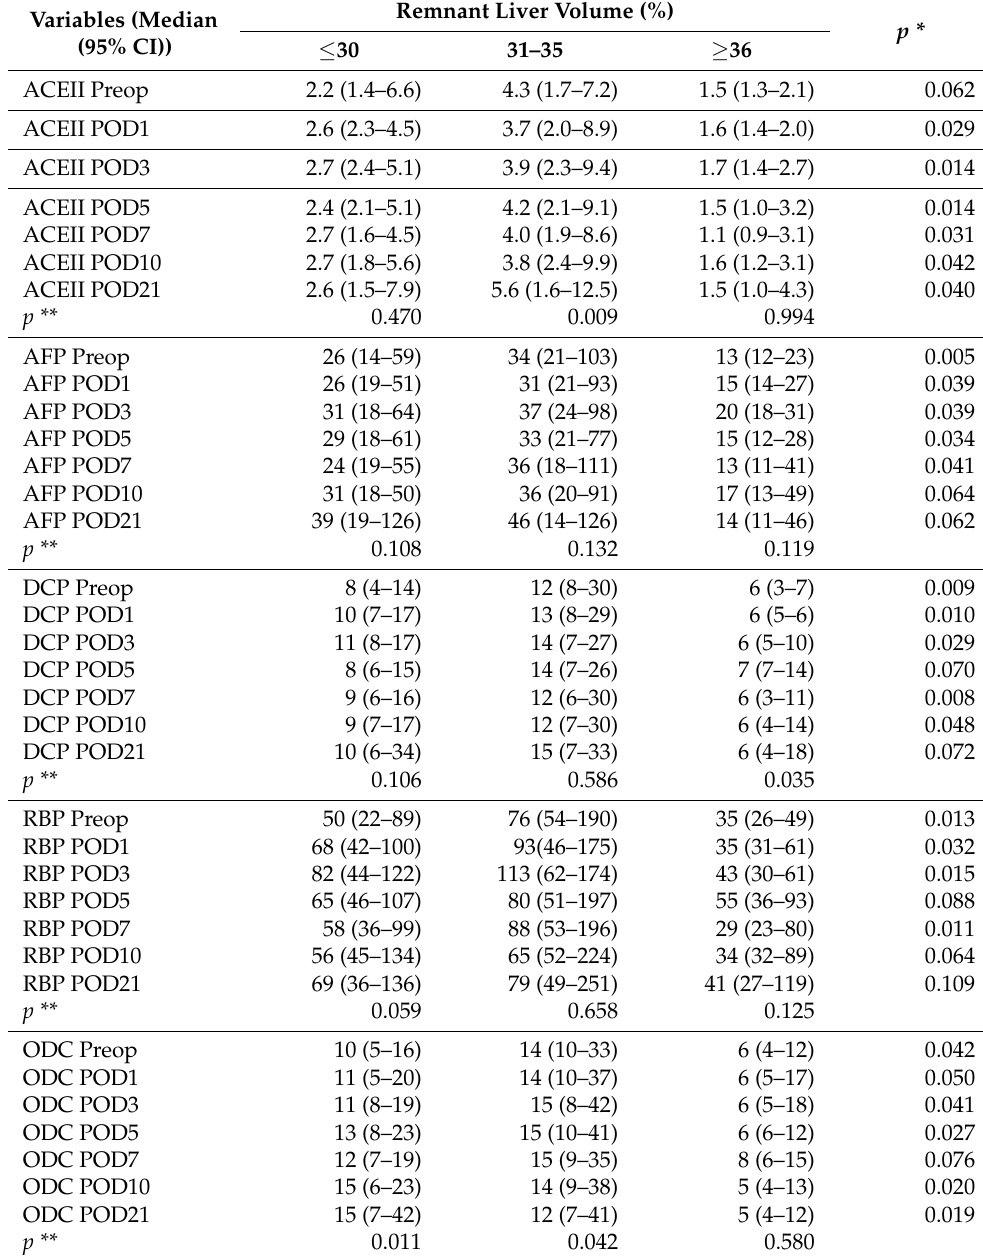
Table 9. Comparison of the study subgroups created according to the percentage of remnant liver volume in terms of regeneration-related biochemical